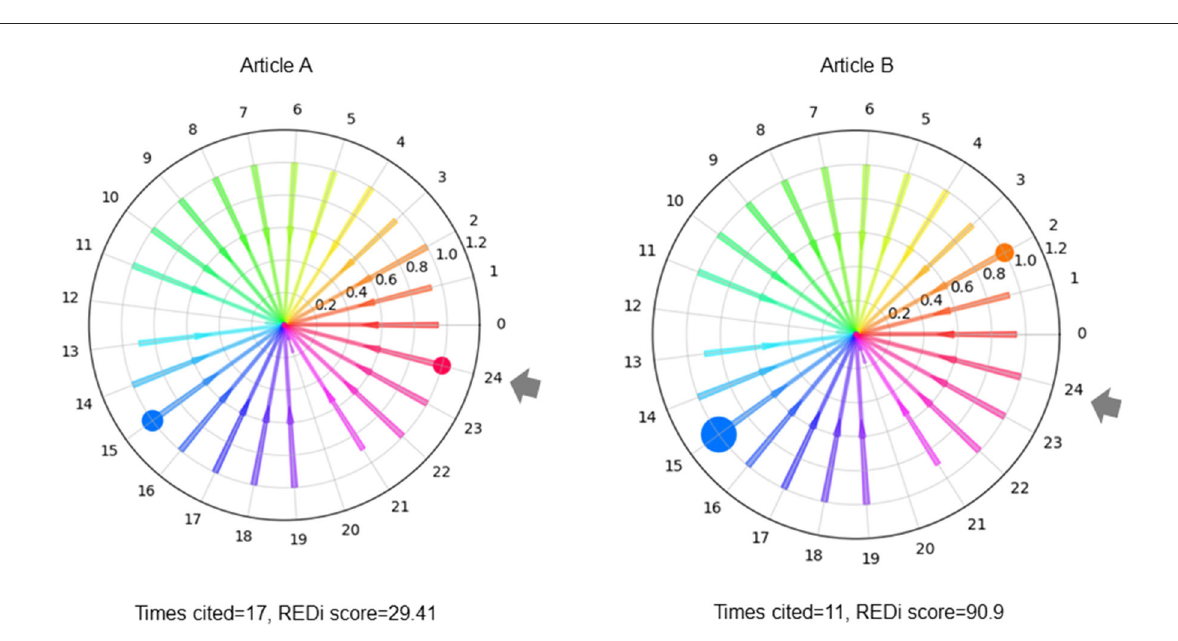
FIGURE2 Citation status and REDi score. Even for papers cited to the same extent, the value of REDi will be greater if the paper is cited more frequently from a different field than the field to which it belongs. Numbers indicate fields. Gray arrows indicate the field to which the paper to be evaluated belongs. Bubbles indicate citation frequency in the